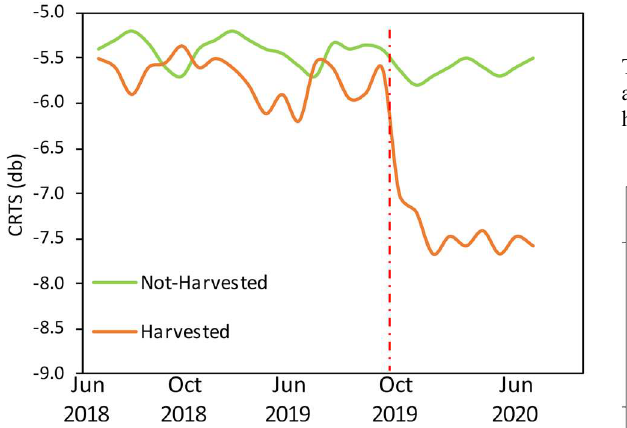
Figure 4 . CRST average profiles of RD. Red line is the expected winter cutting moment considering the 2019 silvicultural season.